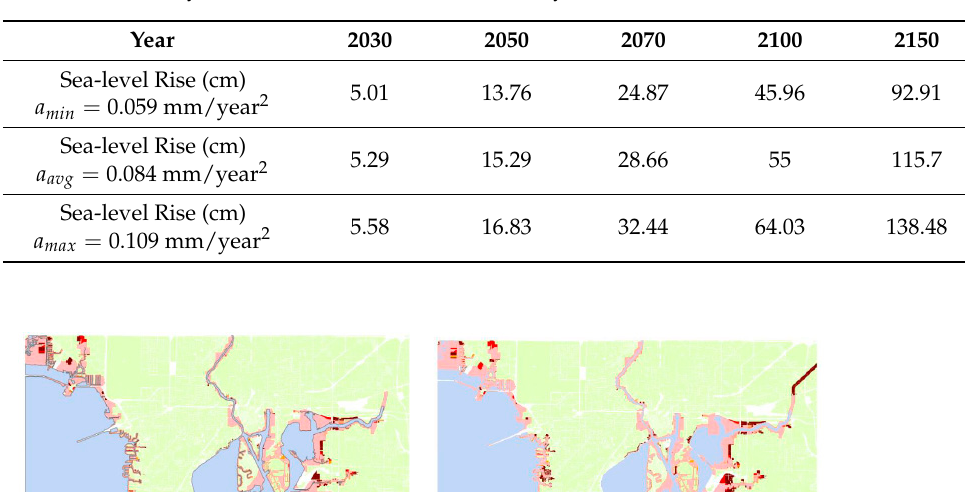
Table 1. Predicted Sea-Level Rise (years 2030–2150) Using Corrected Sea-Level Rise Acceleration of